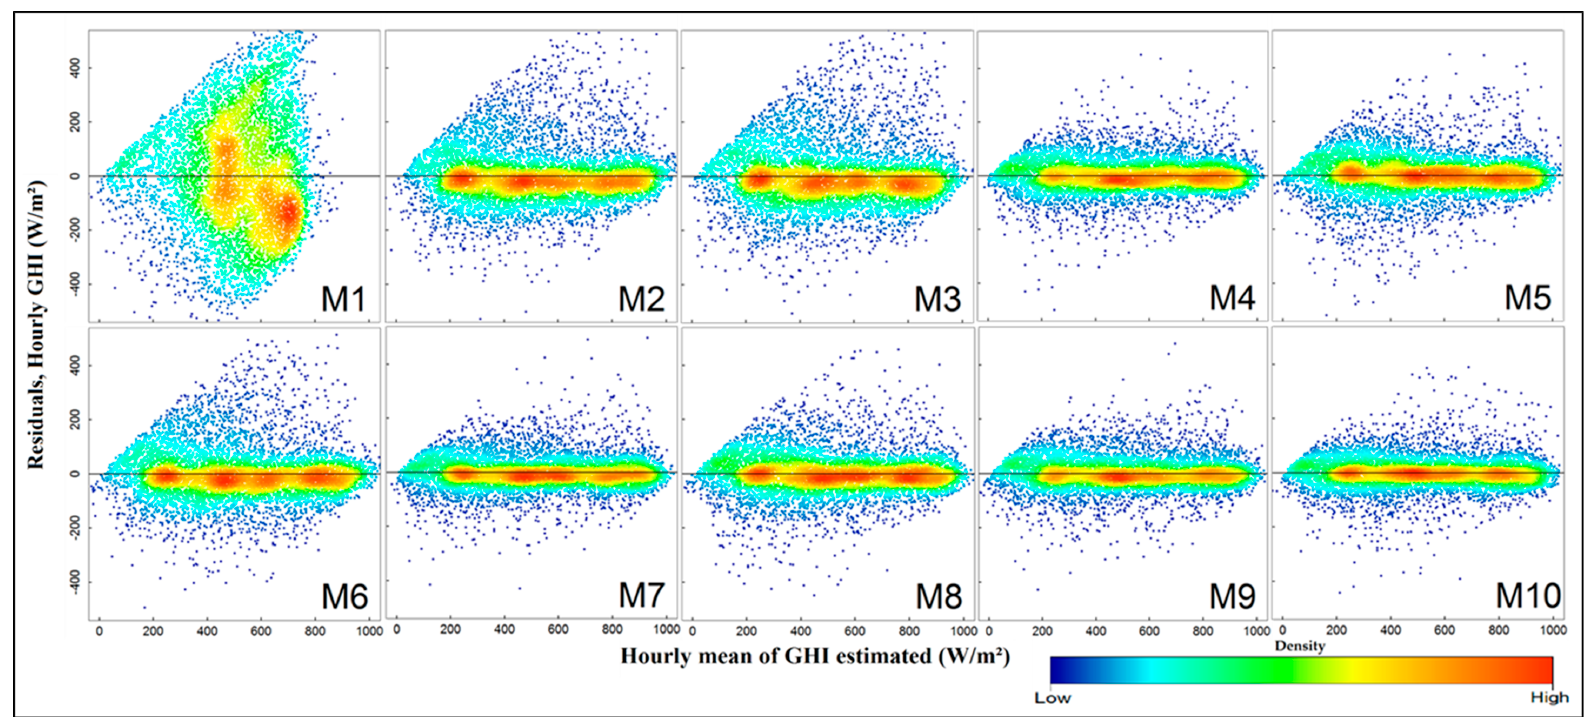
Figure 7. Scatterplots of hourly GHI residuals versus ANN model estimated from M1-M10 at test data for overall results at tower stations. The plots clearly reveal that the models were a good fit at M4, M5 and M7–M10 whereas it is not fit at M1 and low fit are seen at M2, M3 and M6.